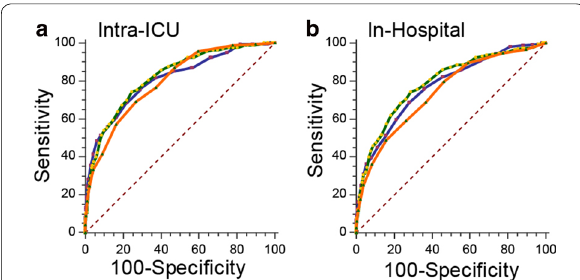
Fig. 2 Pairwise comparison of the prediction model’s receiver operating characteristic (ROC) curves. ROC curves of different severity scores with intra-ICU ( a ) and in-hospital ( b ) mortality as the outcome. Green line—APACHE II; blue line—SAPS 3; orange